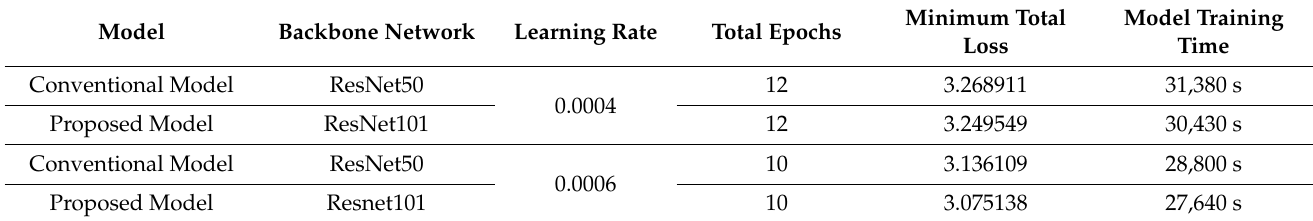
Table 10. Total loss scores for validation data with different learning rates and epochs.